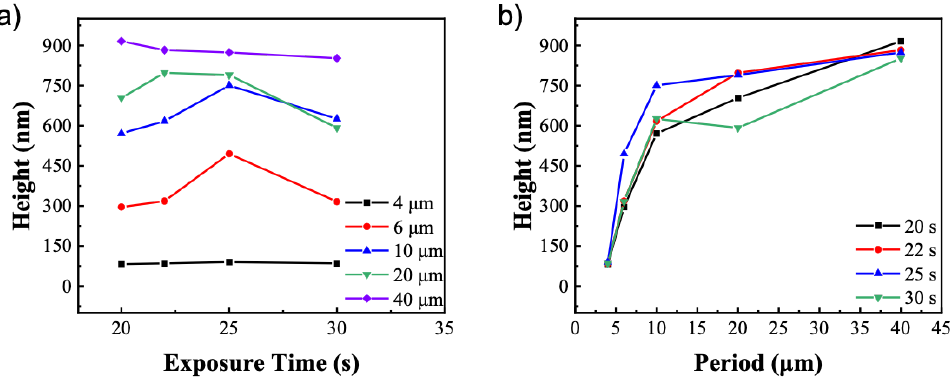
Figure A2. Height (distance to the substrate) of the photo-embossed structures as a function of ( a ) UV exposure time for different periods and ( b ) period of photomask for different exposure times. Table A1. Structure sizes measured for three samples with line pattern (#1), square pattern (#2), and checkboard pattern (#3), respectively. The periods are set to be 10 µ m for all three samples.